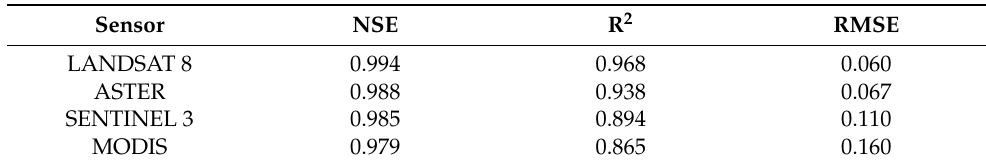
Table 8. Validation